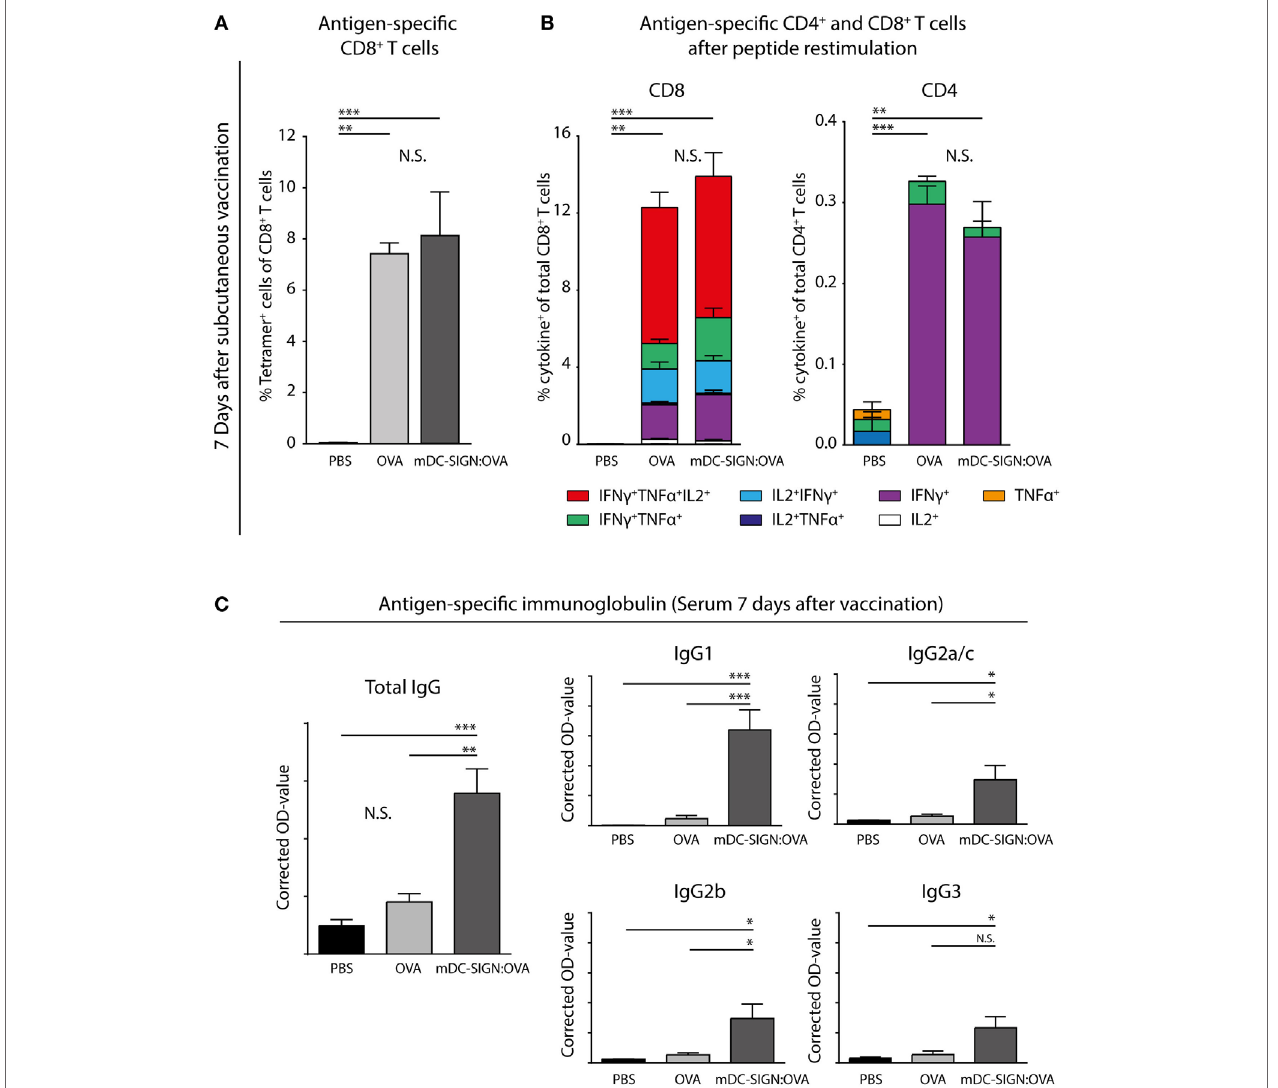
FigUre 6 | One subcutaneous dose of mDC-SIGN-OVA in adjuvant leads to antigen-specific CD8 + and CD4 + T cell responses and an enhanced isotype-switched OVA-specific antibody response. (a) Antigen-specific CD8 + T cells in splenocytes 7 days after vaccination as measured by H2-kb-SIINFEKL tetramer staining. (B) T cell re-stimulation through incubation with cognate antigen and intracellular cytokine staining reveals polyfunctional antigen-specific CD8 + and CD4 + T cell responses. (c) Antigen-specific antibody capture ELISA reveals antigen-specific immunoglobulin production in the serum of mice vaccinated with mDC-SIGN-OVA (7 days after vaccination; 1:400 serum dilution). All data represented as mean ± SEM ( N = 5 per group). Two-way analysis of variance with Tukey post hoc ; * P < 0.05, ** P < 0.01, *** P < 0.001, and **** P < 0.0001. Graphs are representative of two individual